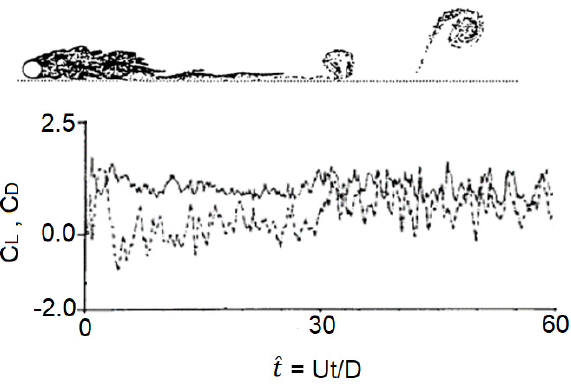
Figure 9. The flow pattern and force coefficients for G/D = 0.5 and Re = 100,000.